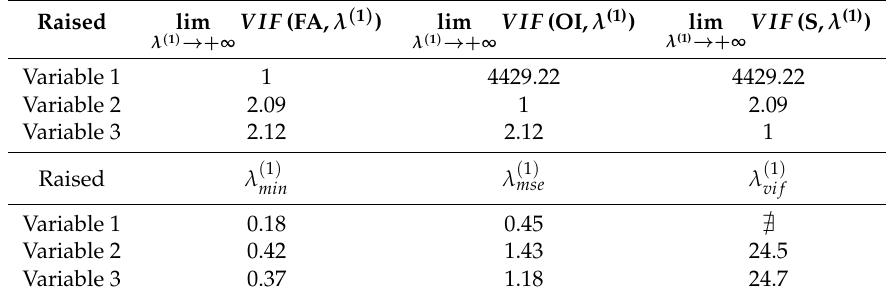
Table 2. Horizontal asymptotes for variance inflation factors (VIF) after raising each variable and λ ( 1 ) ( 1 ) λ . mse , and λ vif